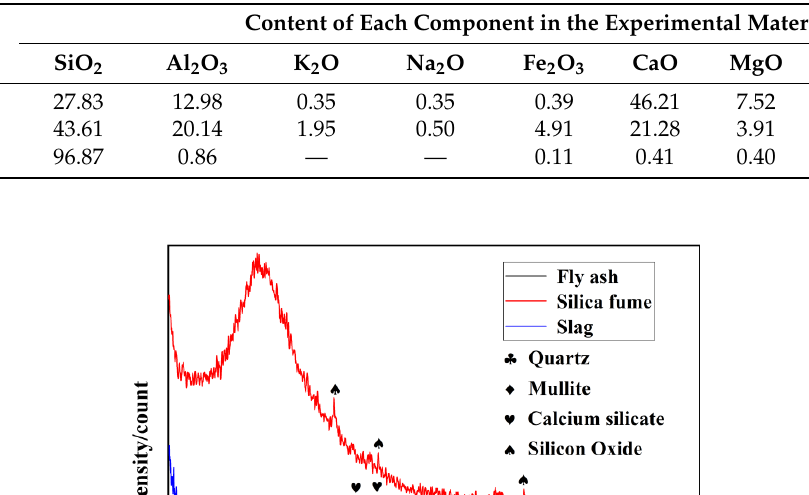
Table 4. Chemical composition of mineral admixtures.